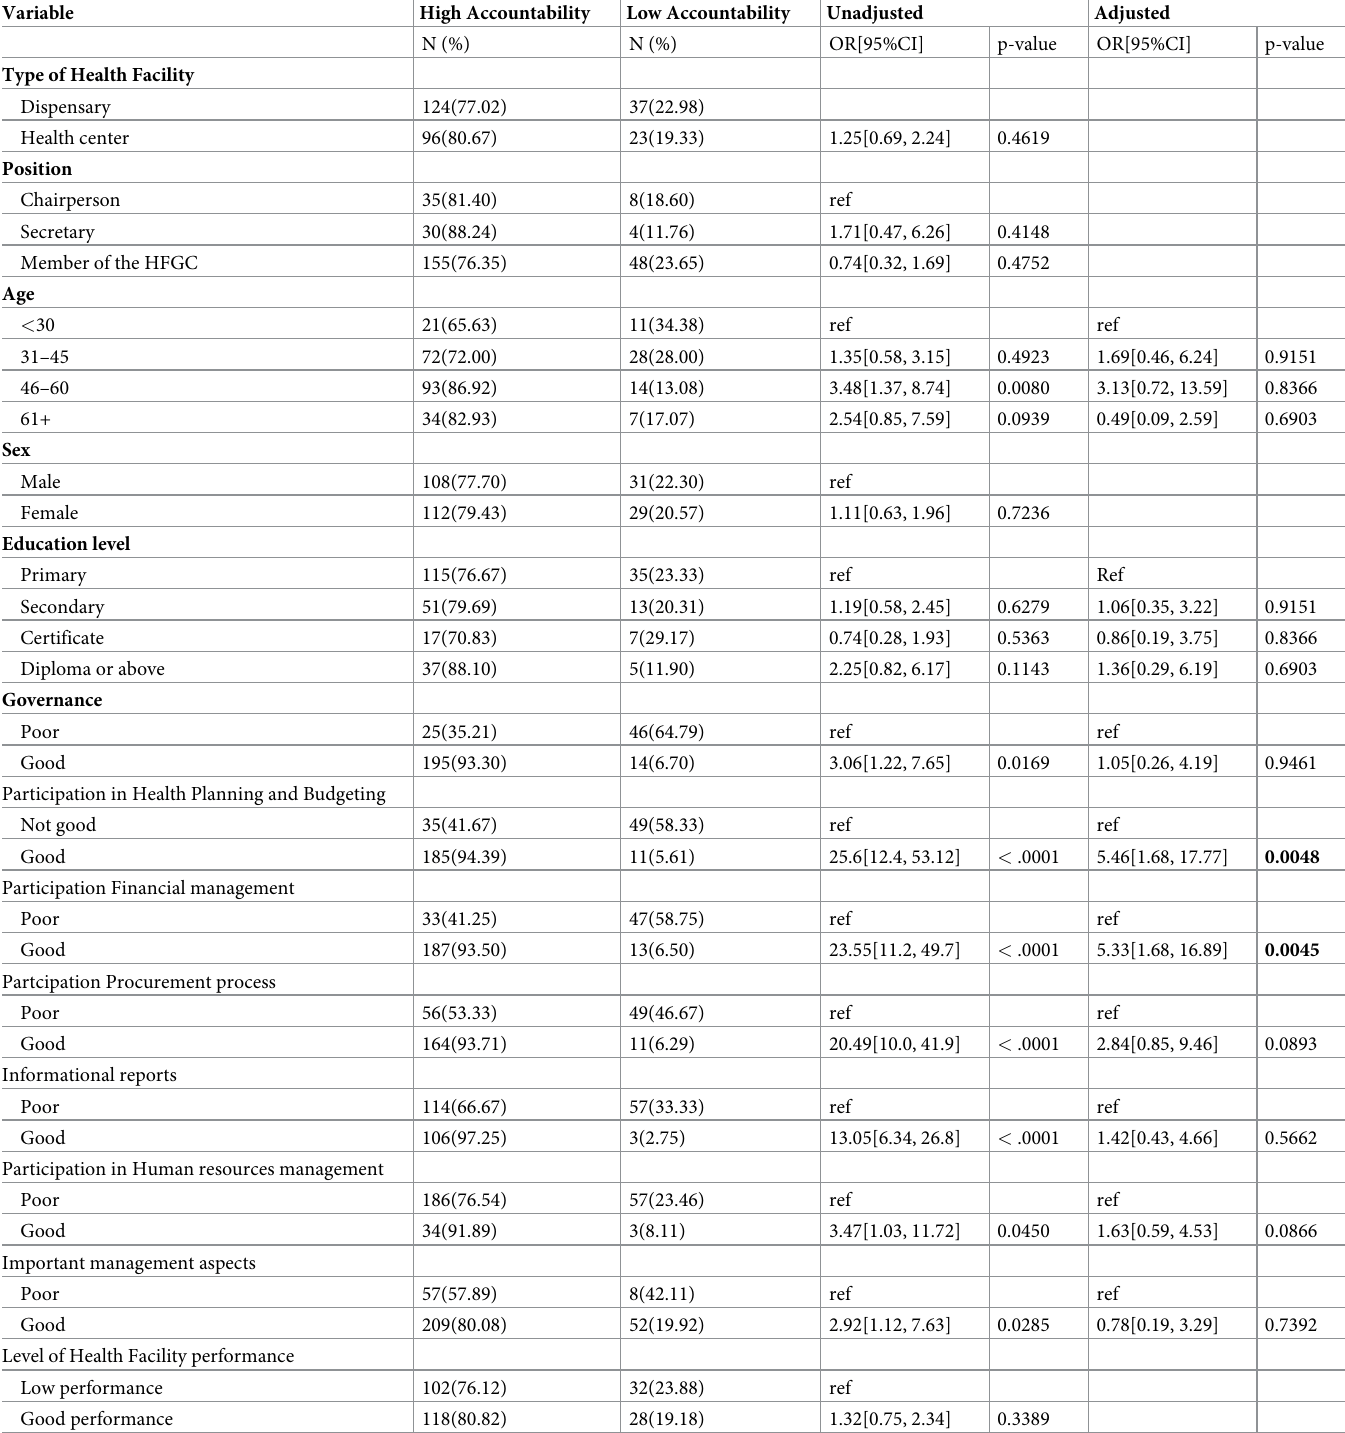
Table 5. Binary logistic analysis for factors associated with the accountability of